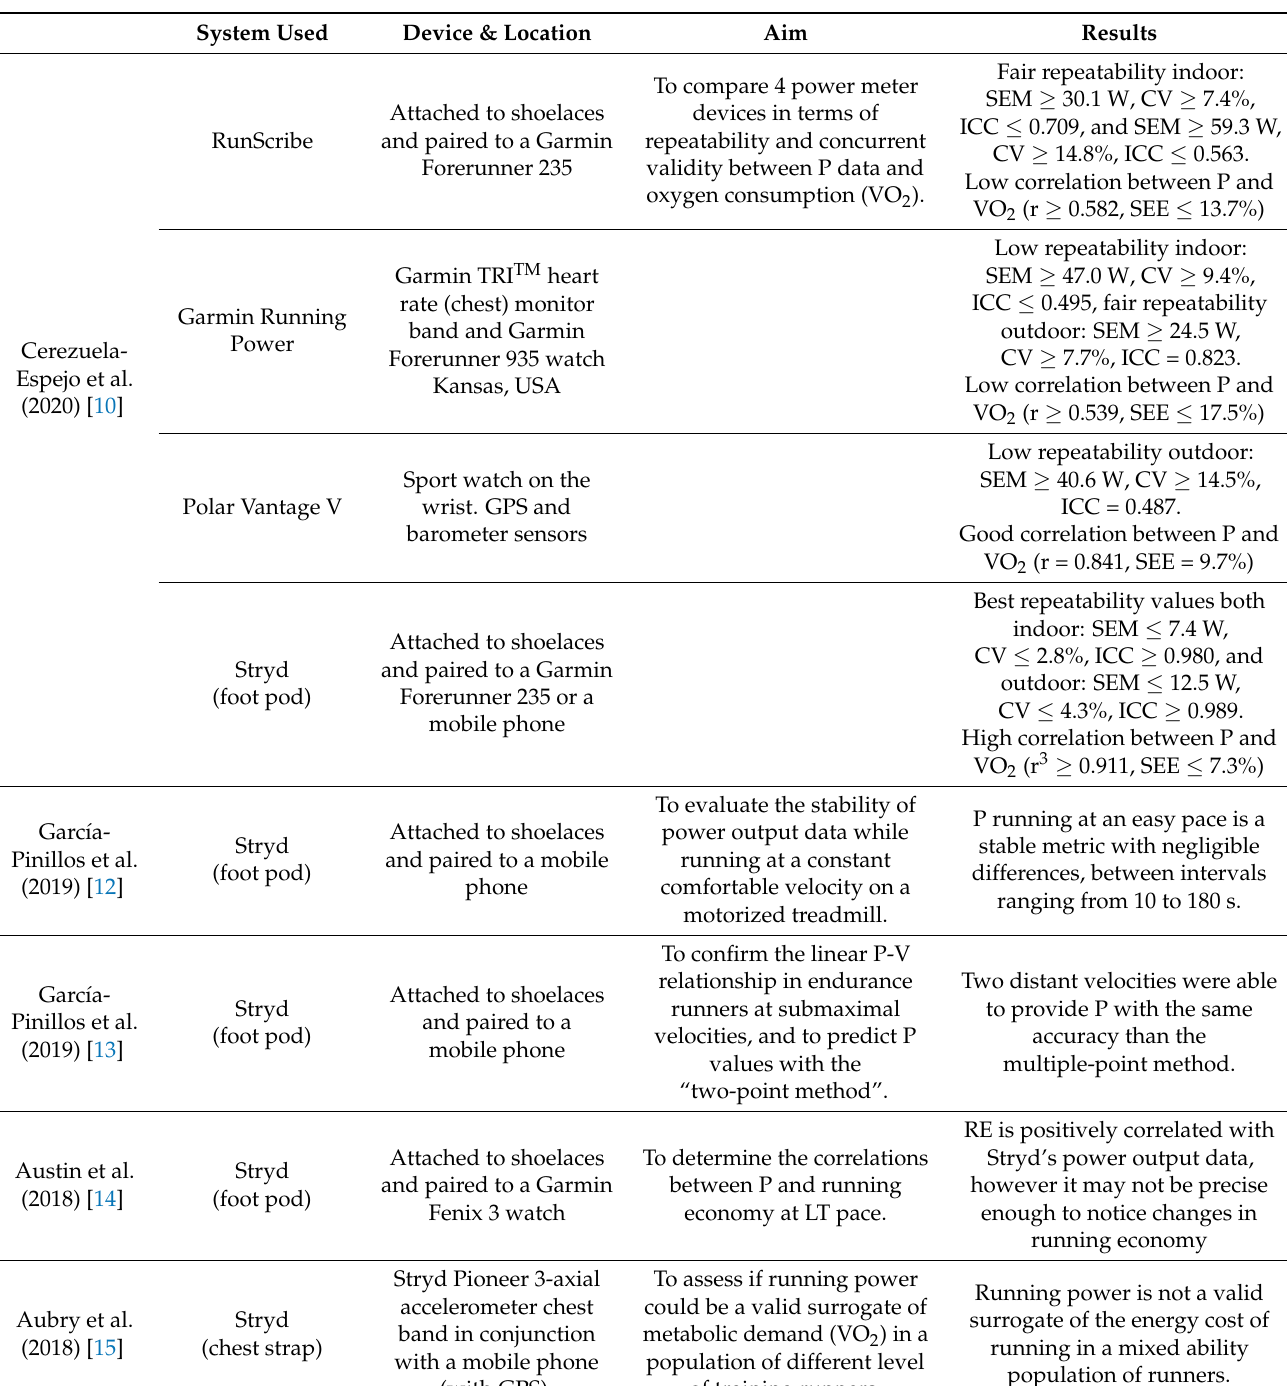
Table 1. Studies ( n = 5) evaluating the use of wearable power meters or using their power output data during running